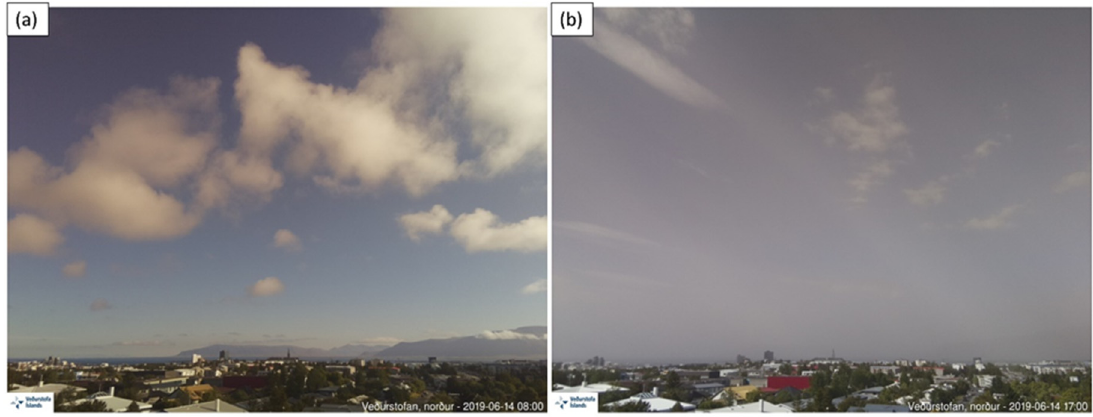
Figure 5. Photos taken by the web camera at IMO at 08:00 UTC ( a ) and 17:00 UTC ( b ), 14 June, 2019, looking northward. The distant mountain on the right-hand side is Mt. Esja.